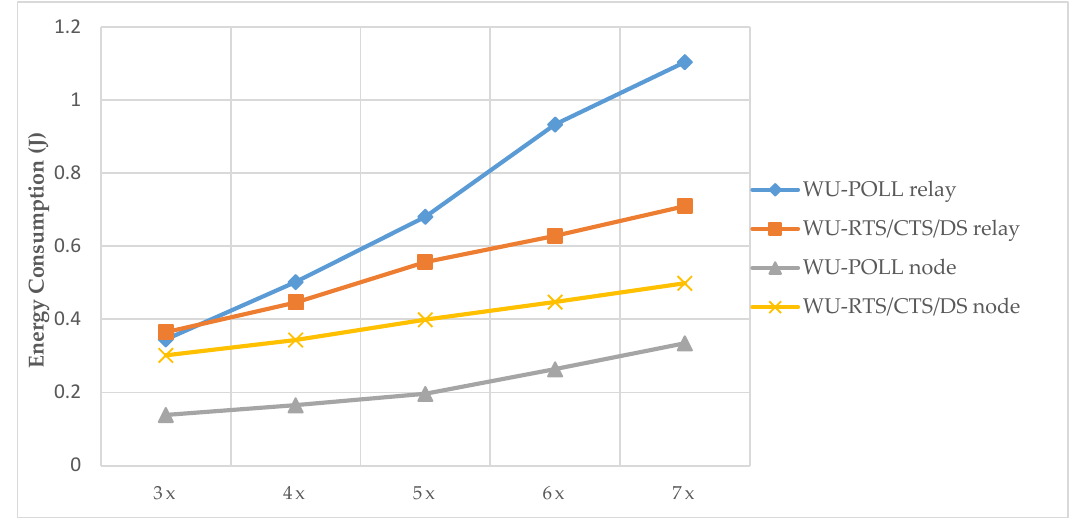
Figure 9. Relay energy consumption (X: Δx: number of nodes per the hop).